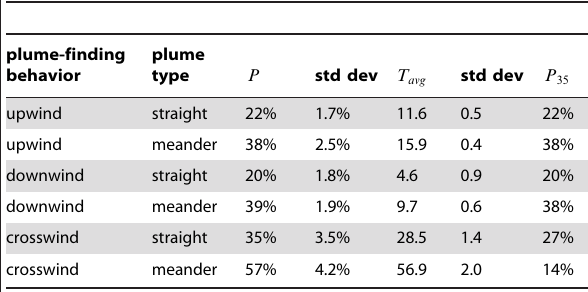
Table 3. A comparison of plume-finding behaviors in straight and meandering plumes.